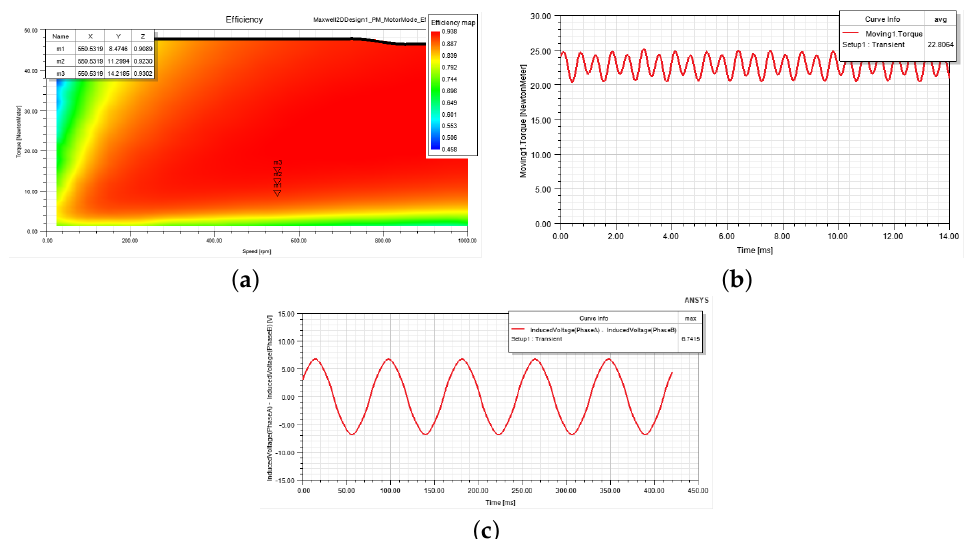
Figure 19. ANYSYS Maxwell 2D ACT Analaysis results for ( a ) efficiency, ( b ), torque at 550 r/min, and ( c ) back emf